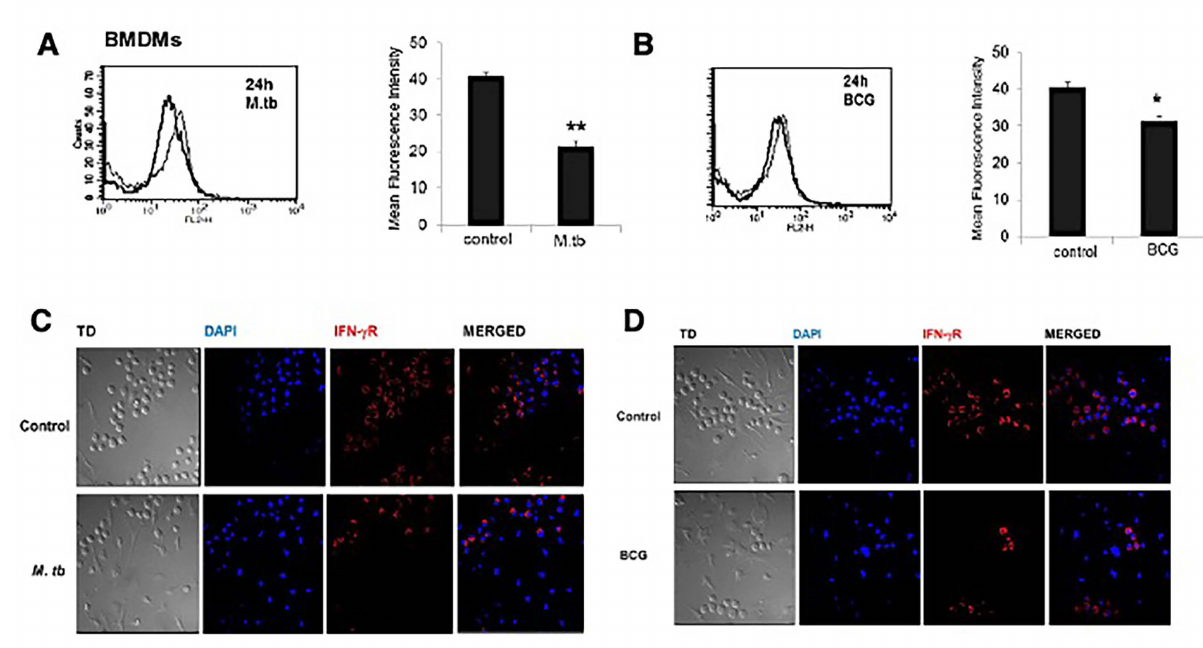
Figure 2: Mycobacteria downregulate IFN-γR expression on murine macrophages. Mouse BMDMs were infected with either (A) M. tb H37Rv or (B) M. bovis BCG at 2MOI for indicated times. IFN-γR levels were monitored by flow cytometry. Thin lines indicate receptor levels in uninfected cells whereas bold lines represent receptor levels in infected cells. Bars adjacent to histogram depict the summarized MFI values. *p<0.05 and **p<0.01, using Student’s t -test between control and infected groups. Data expressed as mean ± S.D (n=3). Confocal images of murine BMDMs showing surface levels of IFN-γR (red) infected with 2MOI M. tb H37Rv (C) or M. bovis BCG (D) for 24h. Cells were incubated with biotinylated anti-IFN-γR antibody and probed with Streptavidin PE. Nucleus was stained with DAPI (blue) and microscopy was performed using Nikon A1 laser microscope and analyzed using NIS Elements AR